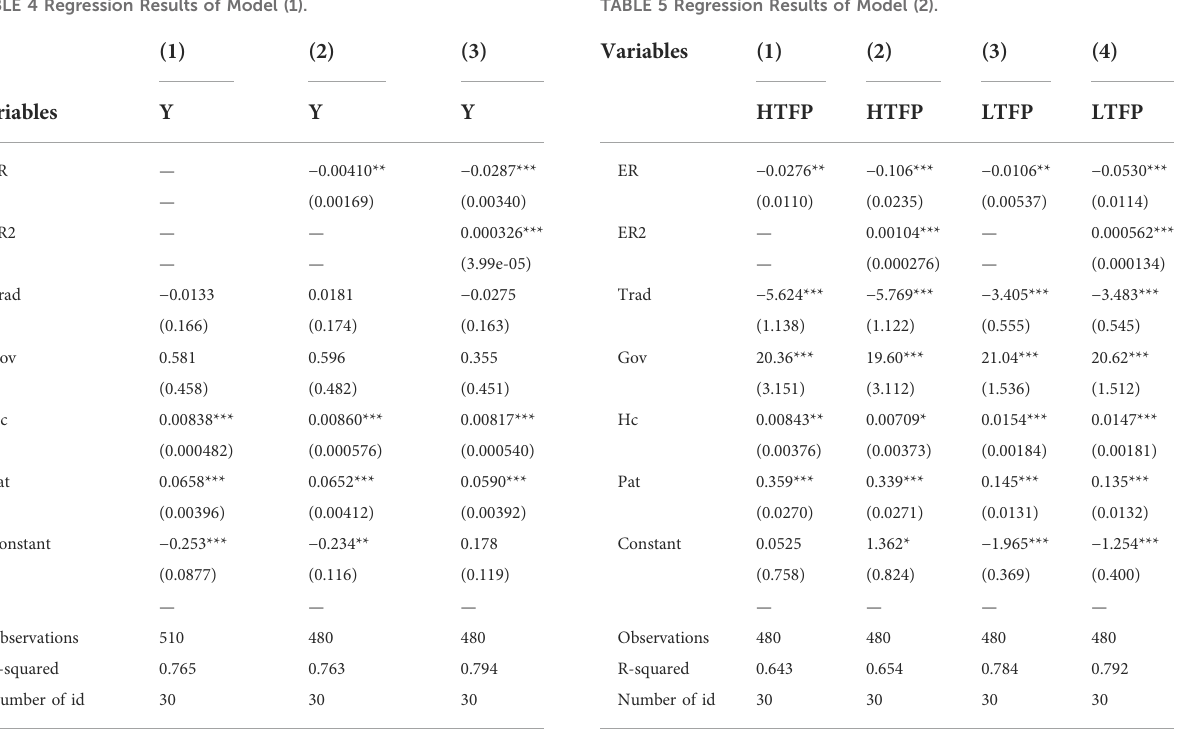
Table 5 veri fi es the impact of environmental regulation on